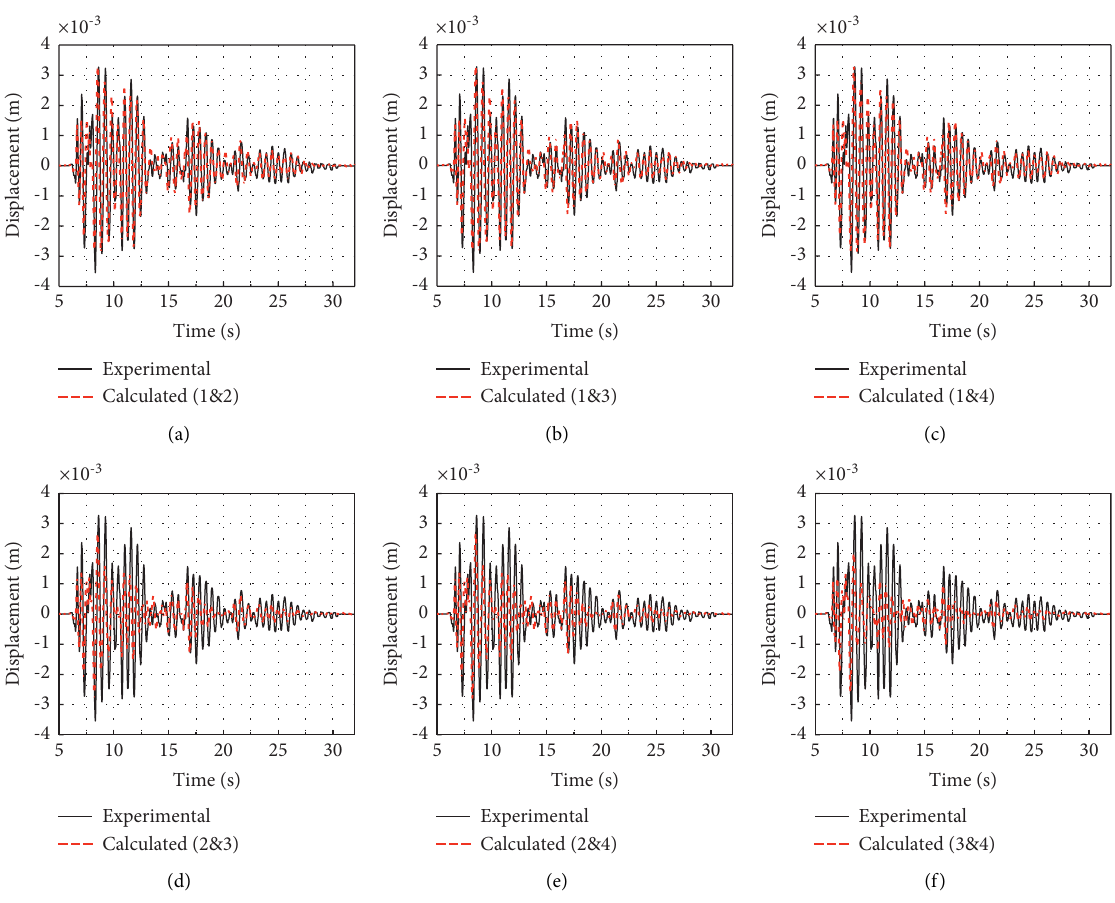
Figure 5: Comparison of calculated and experimental displacement curves of the isolation layer with RD based on frequency pairs (case 207): (a) 1&2, (b) 1&3, (c) 1&4, (d) 2&3, (e) 2&4, and (f) 3&4. Table 6: Calculation schedule of PGA �